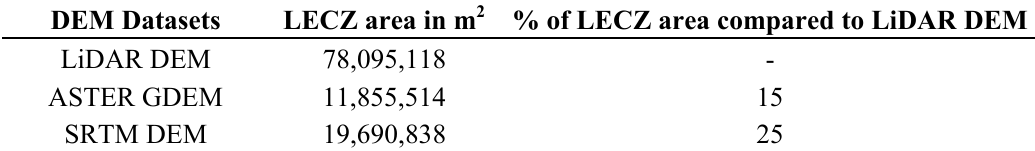
Table 2. Numbers and percentages of the estimated LECZ